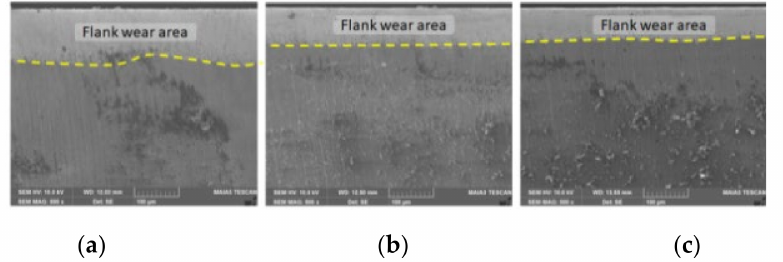
Figure 5. SEM micrographs of the wear of the flanks (lamellae) of the active side of the dental milling cutter at rotational velocity of 20,000 rpm and the feed rate of: ( a ) 0.10 mm/tooth ( b ) 0.30 mm/tooth; ( c ) 0.50